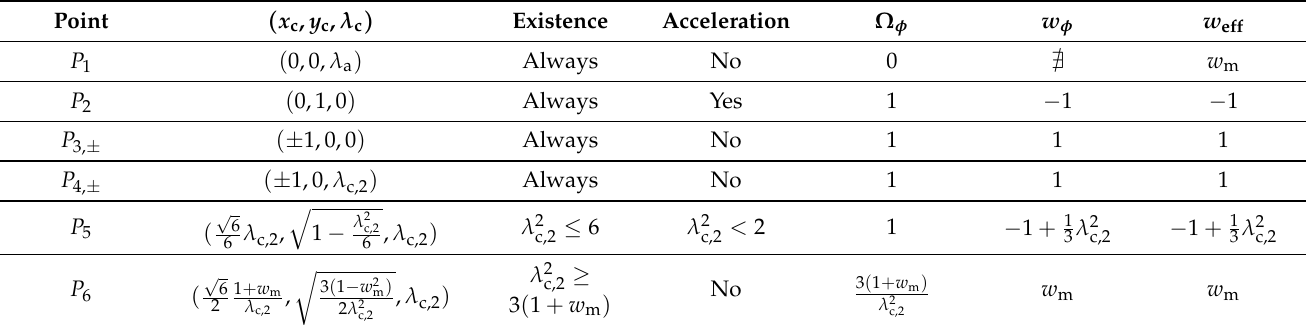
Table 1. Critical points for the dynamical system with the Recliner model. We label with λ a an arbitrary point satisfying the equilibrium condition and together with the coordinates of the critical point, we present its existence, whether it leads to an accelerated expansion phase, the scalar field energy density parameter Ω φ , the equation-of-state parameter for the scalar field and the total one, w φ and w eff ,